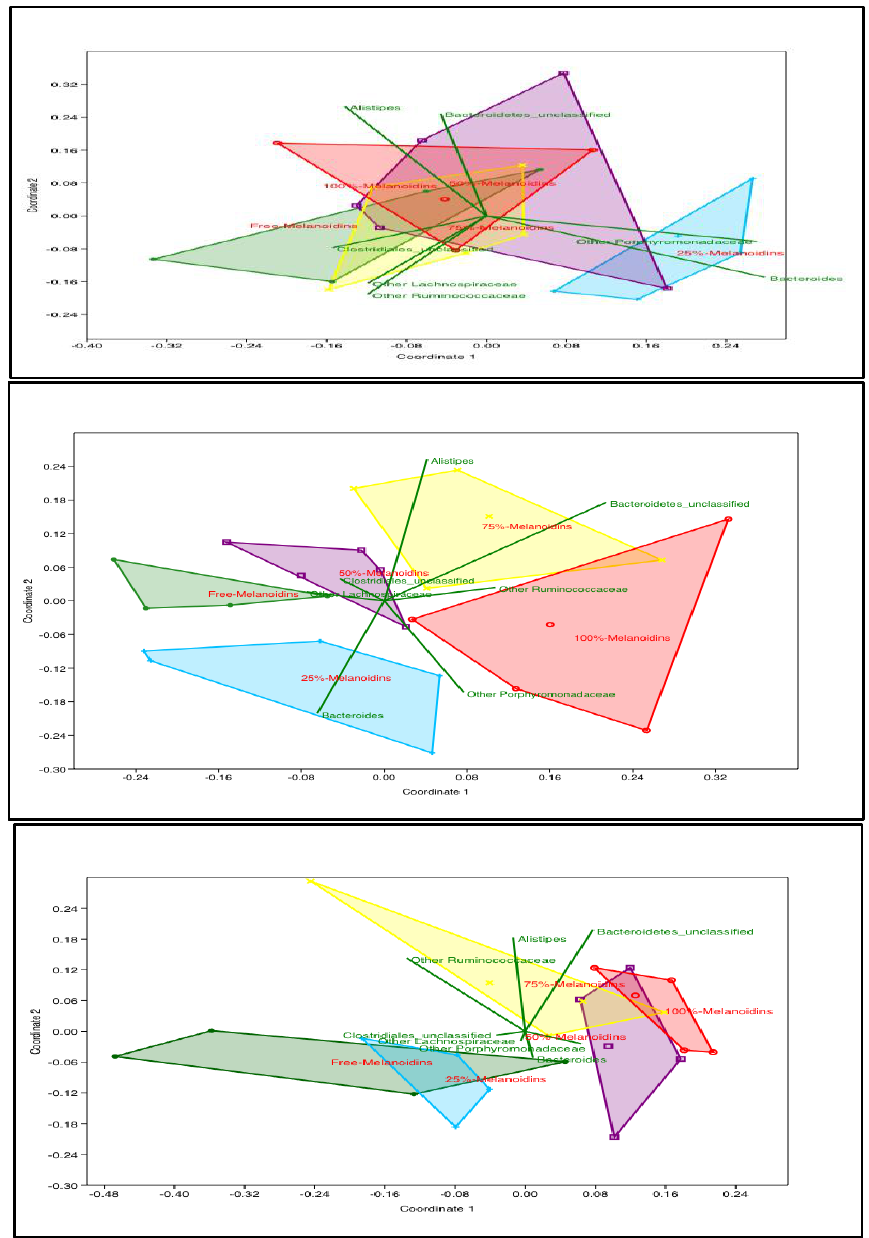
Figure 1 Figure 1. Impact of increasing dietary melanoidin malts on the composition of the gut microbiota (non-metric multidimensional scaling (NMDS)): Day 0 showed no significant di ff erence (ANOSIM p > 0.05); day 7 showed the 25%, 50%, 75%, and 100% melanoidin malt groups to be significantly di ff erent from the 0% group (ANOSIM p < 0.05); day 21 showed the 0% and 25% groups to be significantly di ff erent from 50%, 75%, and 100% groups ( n =